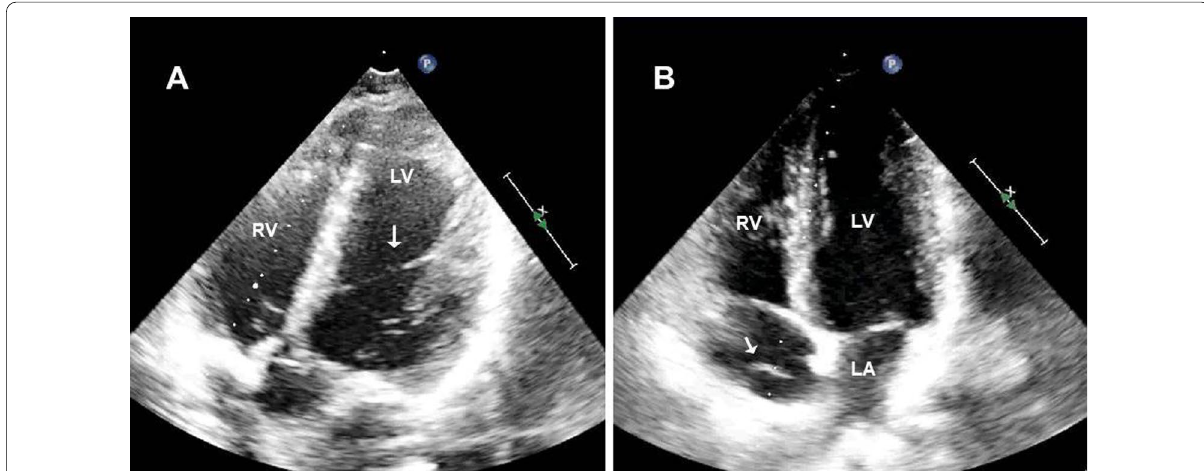
Fig. 1 A Modified apical five-chamber imaging shows the left ventricular false tendon extending between the interventricular septum and the left ventricle lateral wall. B In the four-chamber imaging of the same patient, the Chiari’s network is observed in the right atrium